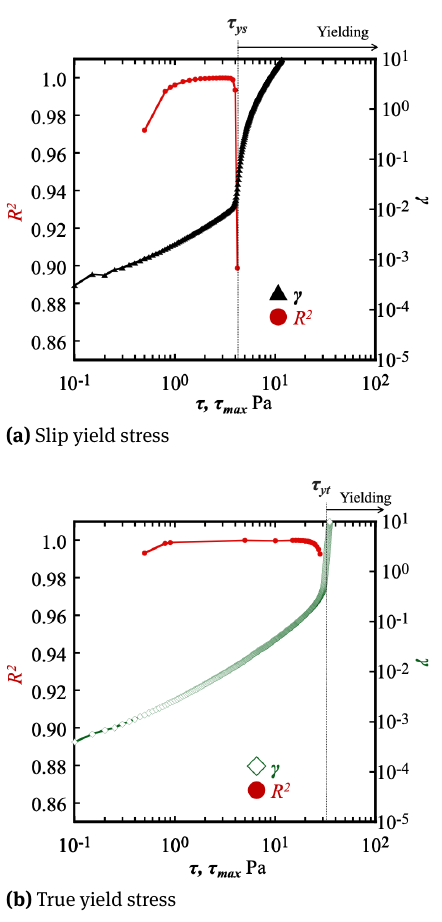
Figure 14: Strain contribution of viscosity and elasticity to the slip yield characteristic in the stress-ramp test. (a) The viscoelastic contribution in the slip yield strain and (b) the relationship between the slip yield stress and the ratio of viscous and elastic strains. The deviation of the experimental yield strain from the Maxwell model is linked to the viscous strain. The yield stress for each stress-ramp rate is also influenced by the viscous strain